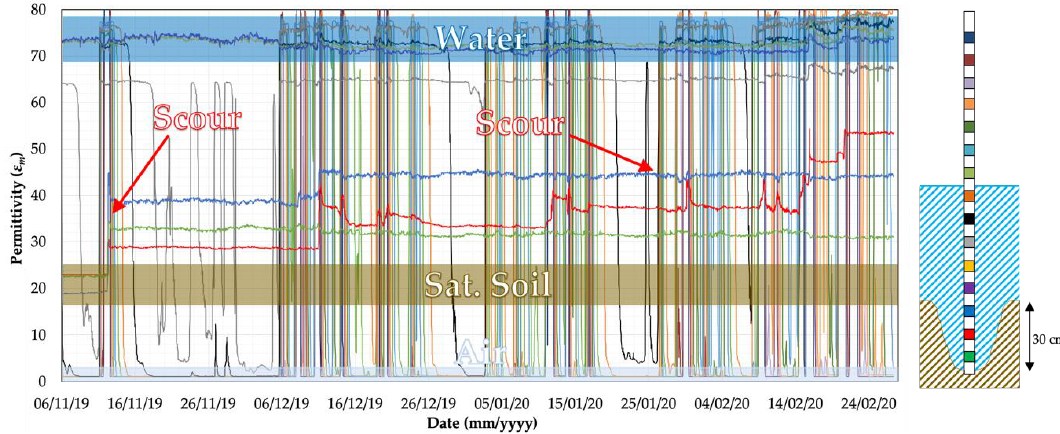
Figure 19. Detection of scour hole by Probe 2.